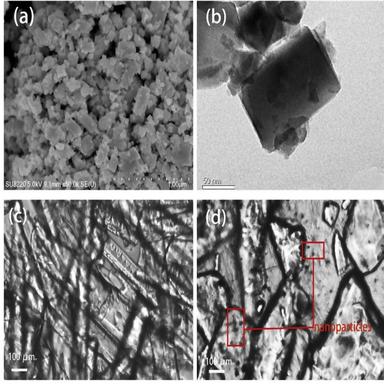
SEM imagines (a) and TEM imagines (b) of CsxWO3 nanoparticles and Optical microscopy images of CaCl2·6H2O without (c) and with CsxWO3 nanoparticles (d).